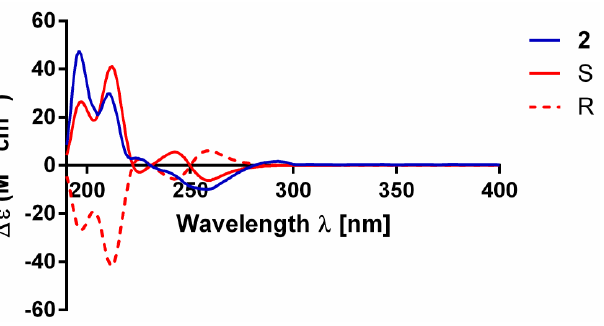
Figure 4. Experimental and calculated electronic circular dichroism (ECD) spectra of compound